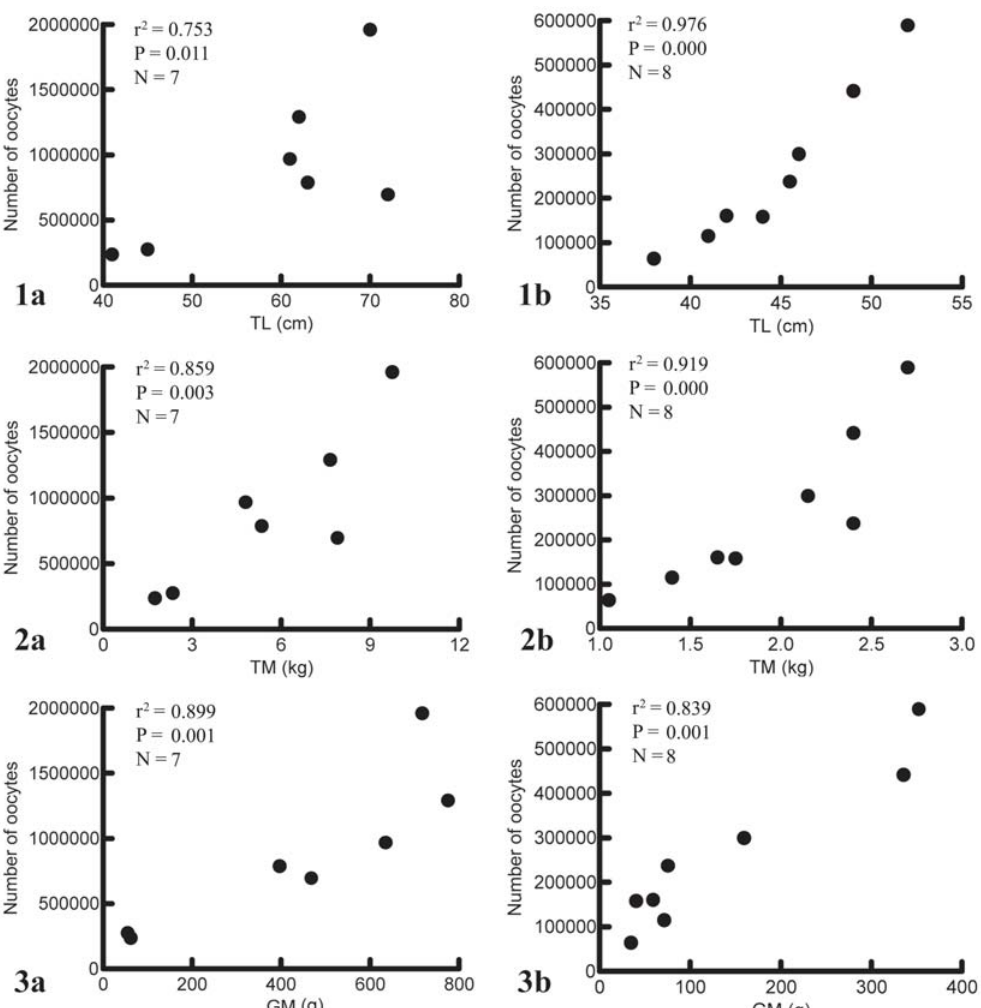
Fig. 8. Relationship between fecundity (number of oocytes) and the TL, TM and GM of P . mesopotamicus in the headwaters (1a, 2a and 3a) and flood area (1b, 2b and 3b), between August 2006 and July